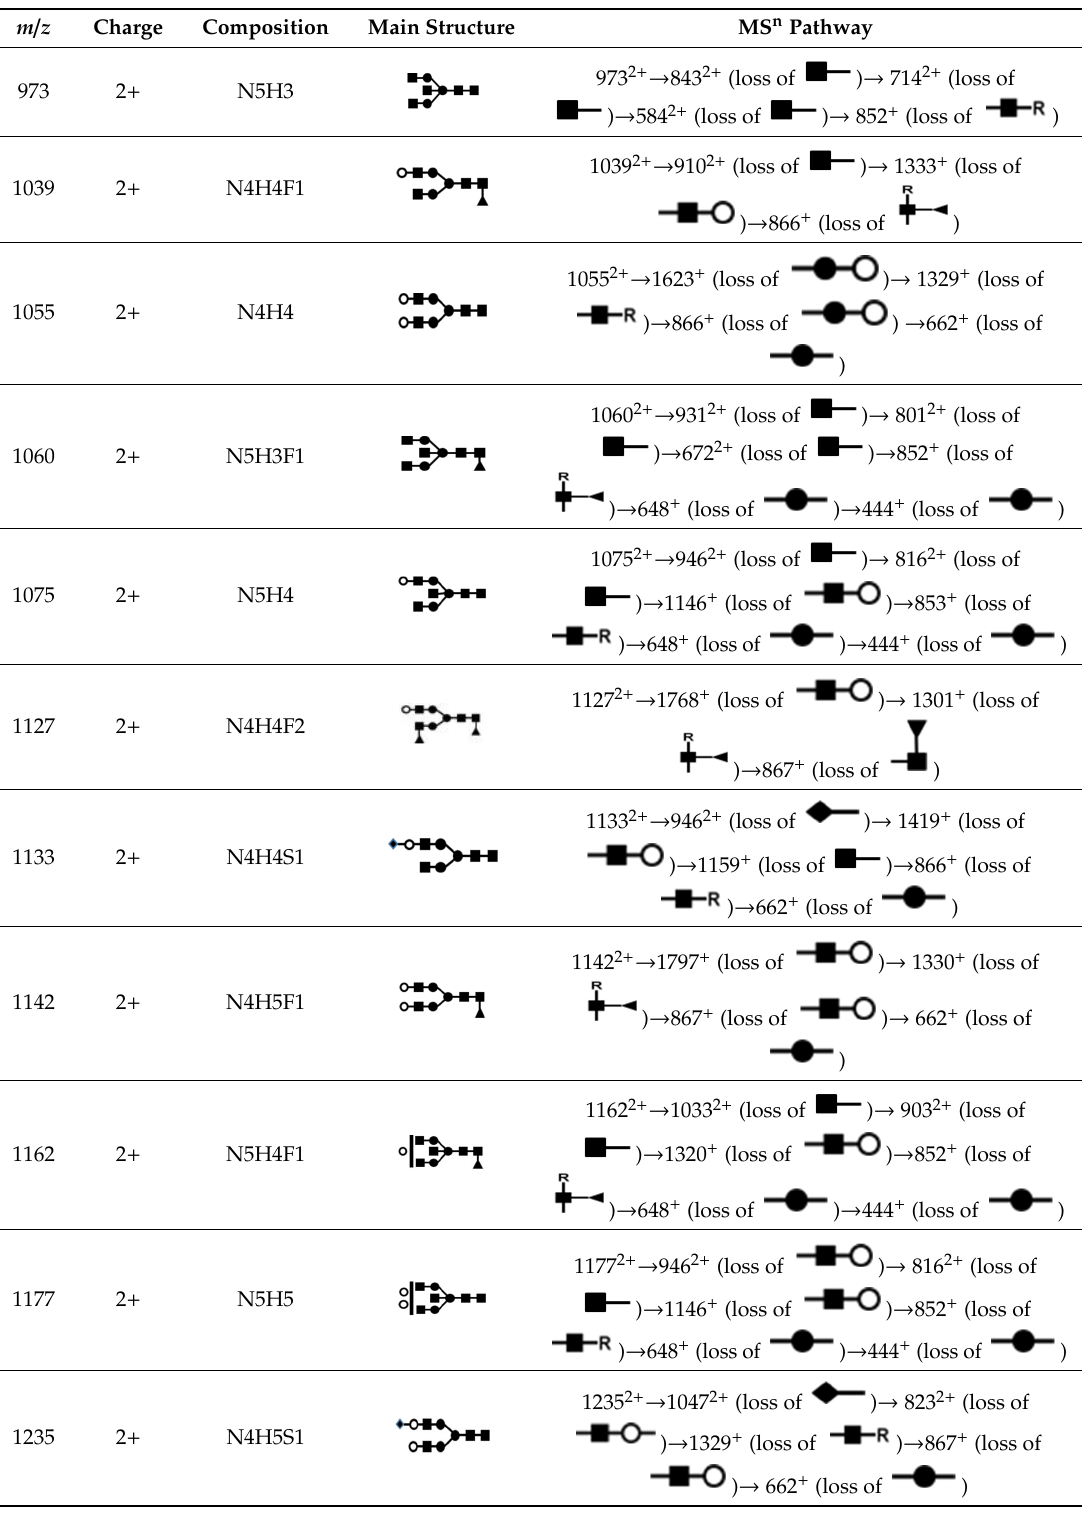
Table 1. Major N-glycans in sera of healthy controls and rheumatoid arthritis patients. m/z